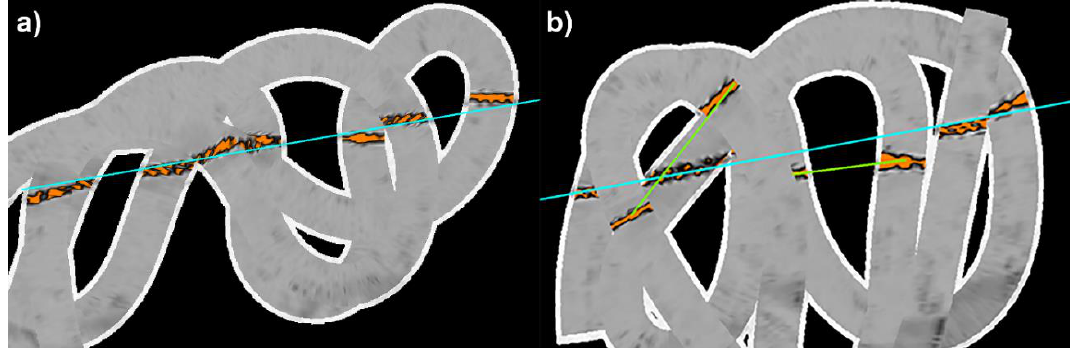
Figure 10. Resulting C-scans for irregular passes positioned with the use of ( a ) GPS PPS and ( b ) GPS. The axis of the scanned drainage grille is presented in the background.